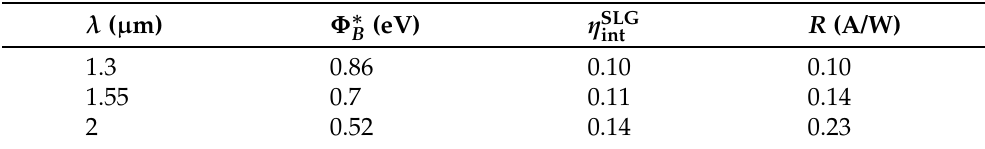
Table 1. Values of the Schottky barrier Φ ∗ optimizing the responsivity ( R )/noise equivalent power B ( NEP ) ratio at the three wavelengths of interest: 1.3 µ m, 1.55 µ m, and 2 µ m at T = 300 K. The corresponding efficiency η SLG and responsivity R , calculated respectively through Equations (2), (3) int and (14), are also shown. SLG is the acronym of single layer